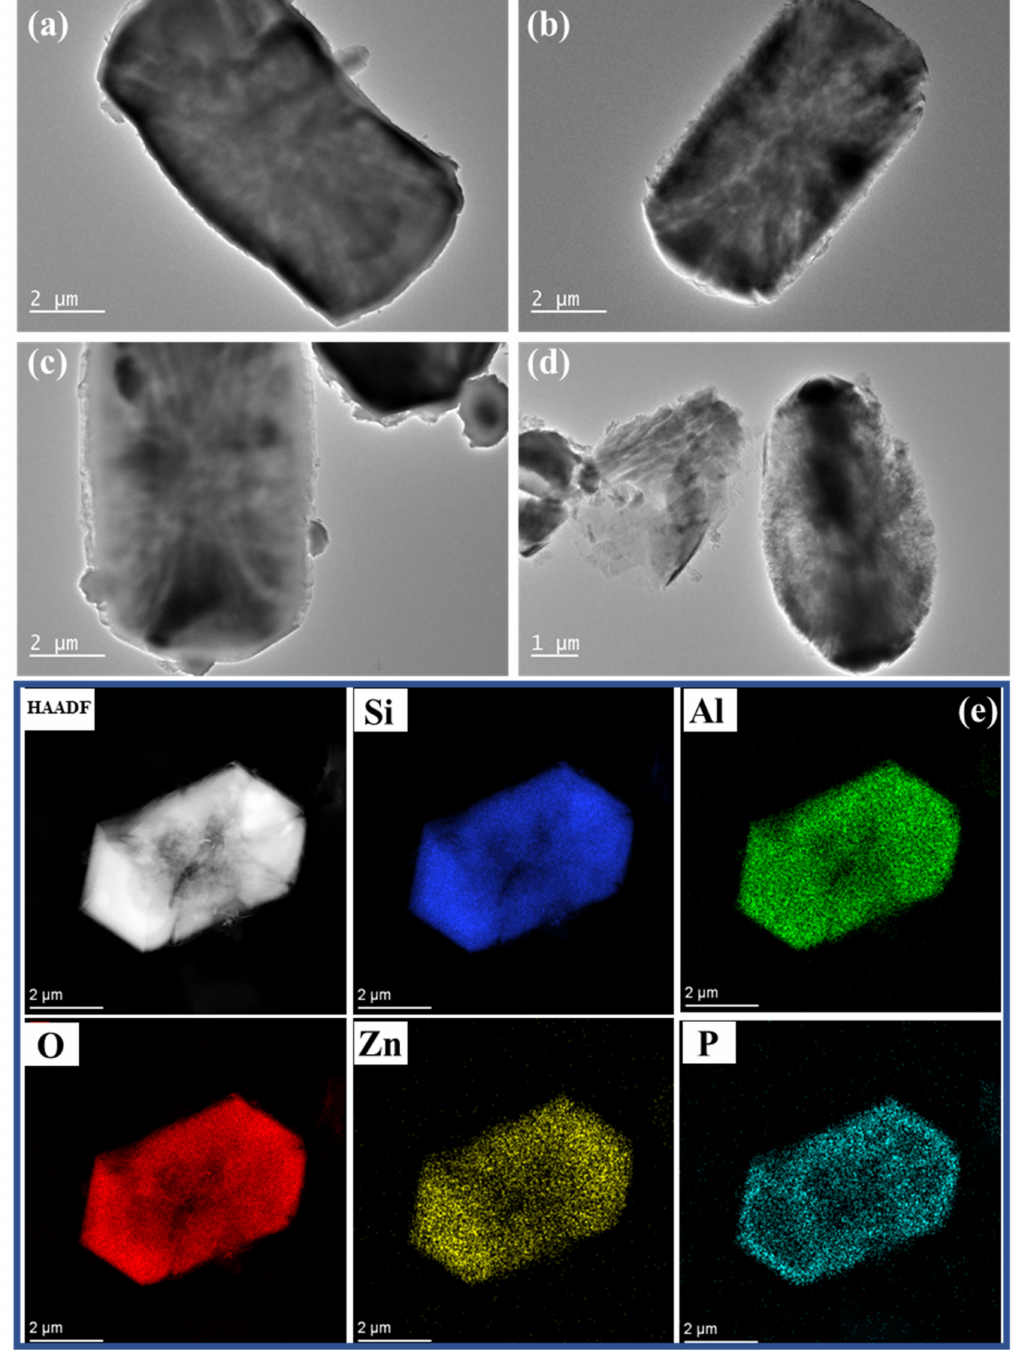
Figure 4. TEM images and energy-dispersive X-ray spectroscopy (EDX) mappings of Zn-P co-modified samples: ( a ) 1.5Zn0.1P/HZSM-5, ( b ) 1.5Zn0.3P/HZSM-5, ( c ) 1.5Zn0.6P/HZSM-5, ( d ) 1.5Zn1.0P/HZSM-5, ( e ) high angle annu- lar dark-field (HAADF) and EDX mappings of